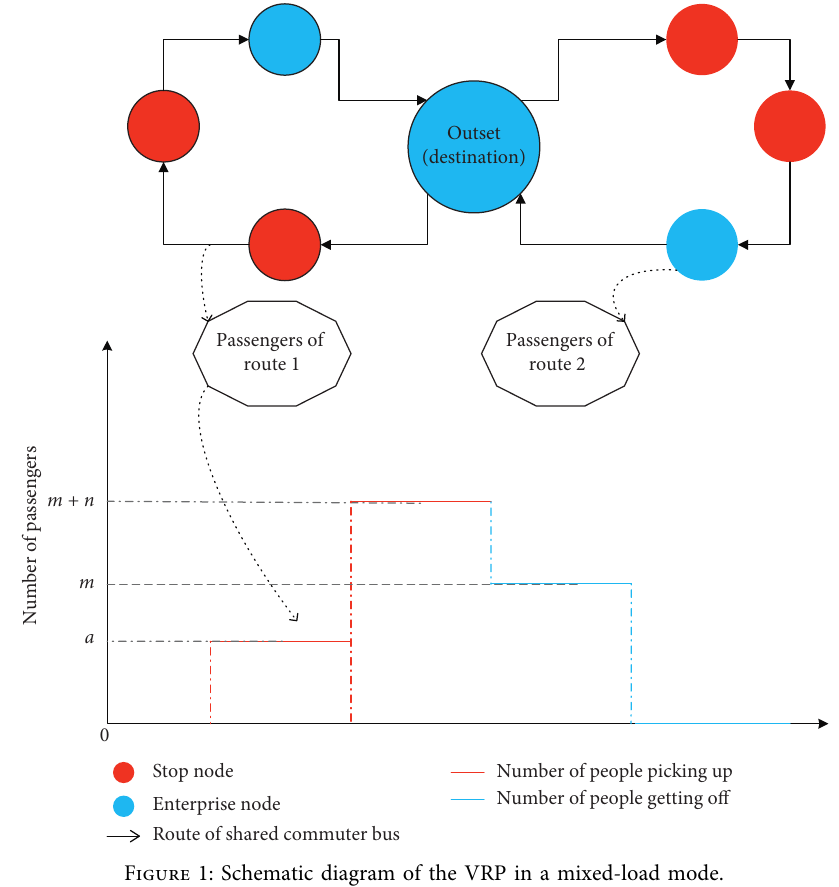
Figure 1: Schematic diagram of the VRP in a mixed-load mode.